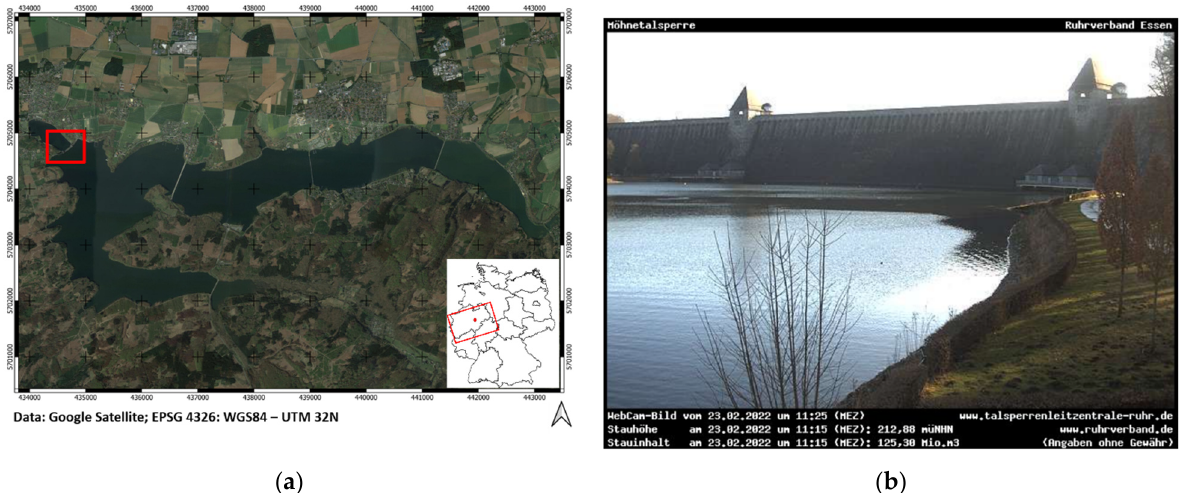
Figure 1. Study area of this investigation: ( a ) Moehne Lake in Western Germany. The position of the Moehne Gravity Dam and the Sentinel-1 coverage are marked in red; ( b ) Photo of the Moehne Gravity Dam (Ruhrverband 2022) [25].